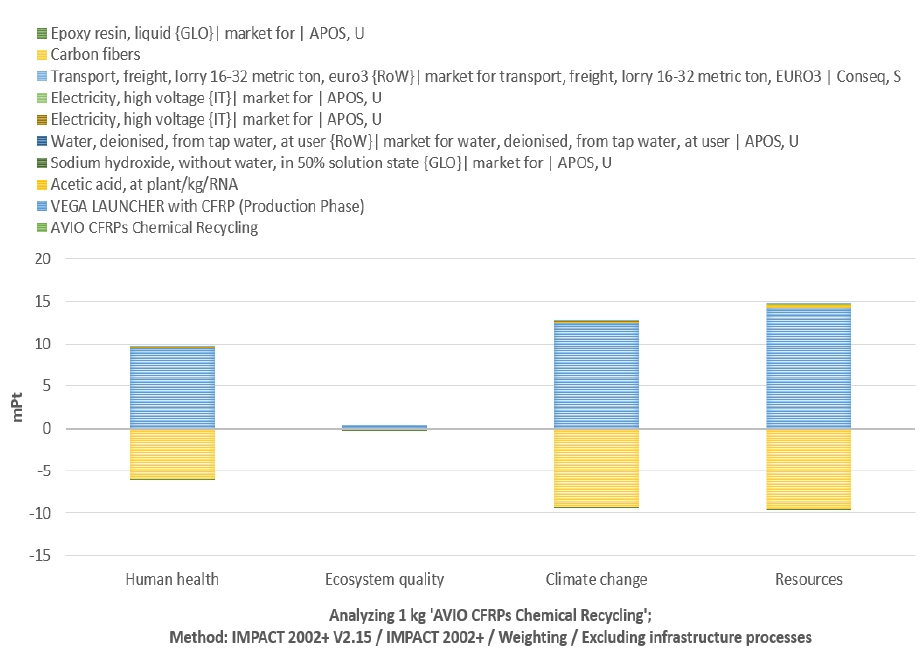
Figure 18. Results of chemical recycling into endpoint categories.